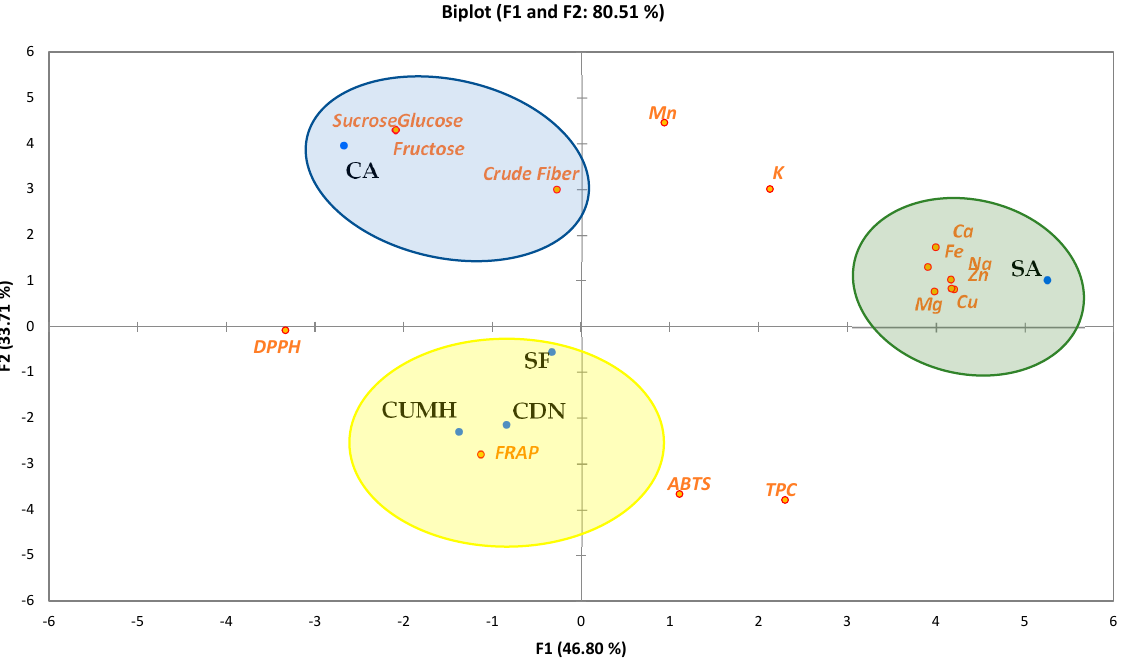
Figure 2. Differences between cultivars for all variables analysed in this study (PCA). Legend: ● Study varible ● Cultivar.